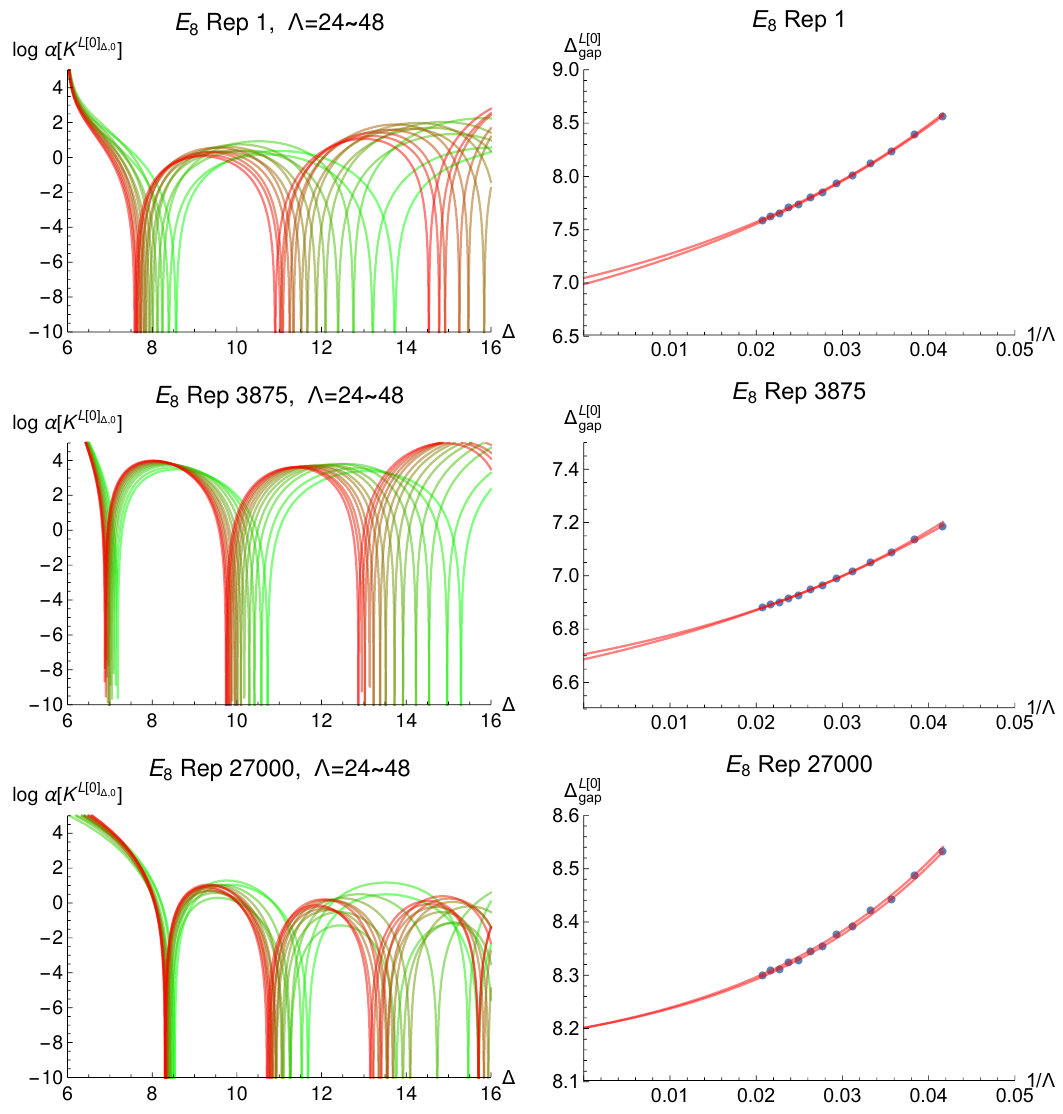
Figure 7 . Left: the extremal functional optimizing the lower bound on C J , acted on the contri- bution of the spin-zero long multiplet to the crossing equation, (cid:11) E [ K L [0] (cid:1) ; 0 ( u; v )], in the 1 , 3875 , 27000 channels of E 8 , plotted in logarithmic scale. Increasing derivative orders (cid:3) = 24 ; 26 ; : : : ; 48 are shown from green to red. Right: the gap (lowest scaling dimension) in each channel at di(cid:11)erent (cid:3), and an extrapolation to (cid:3) ! 1 using the ansatz (8.2), for (cid:3) 2 4 Z and (cid:3) 2 4 Z + 2, separately. For N > 1, the E-string theories have a larger (cid:13)avor group E (cid:13)avor central charge is given